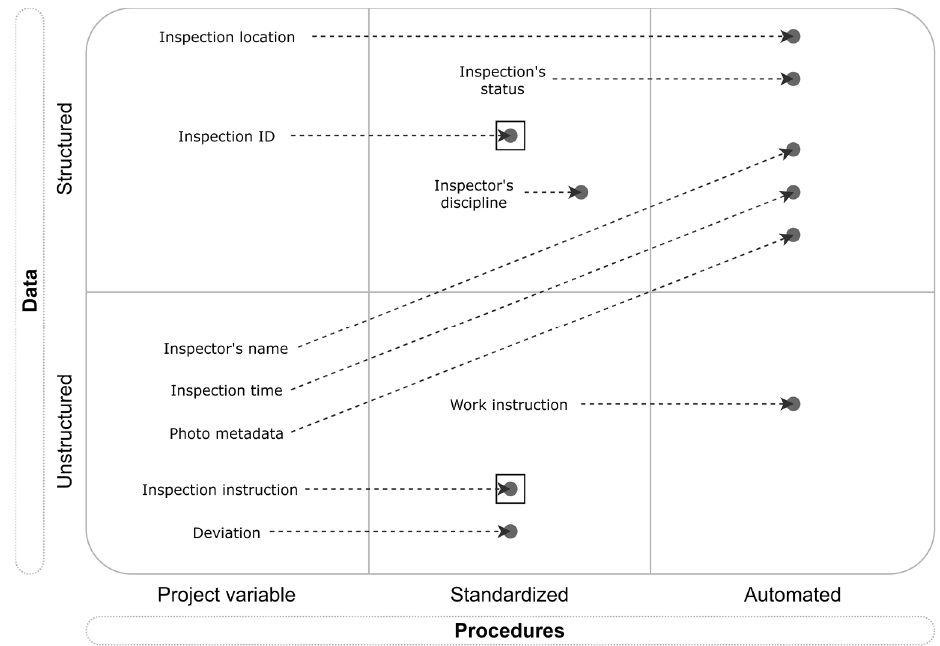
Figure 3. Transformation of data creation and data entry structures and procedures.